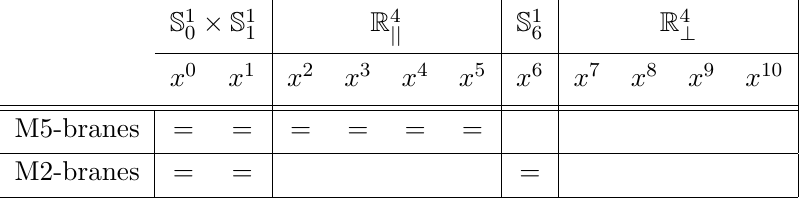
Table 2 . Compact BPS con(cid:12)guration of M5- and